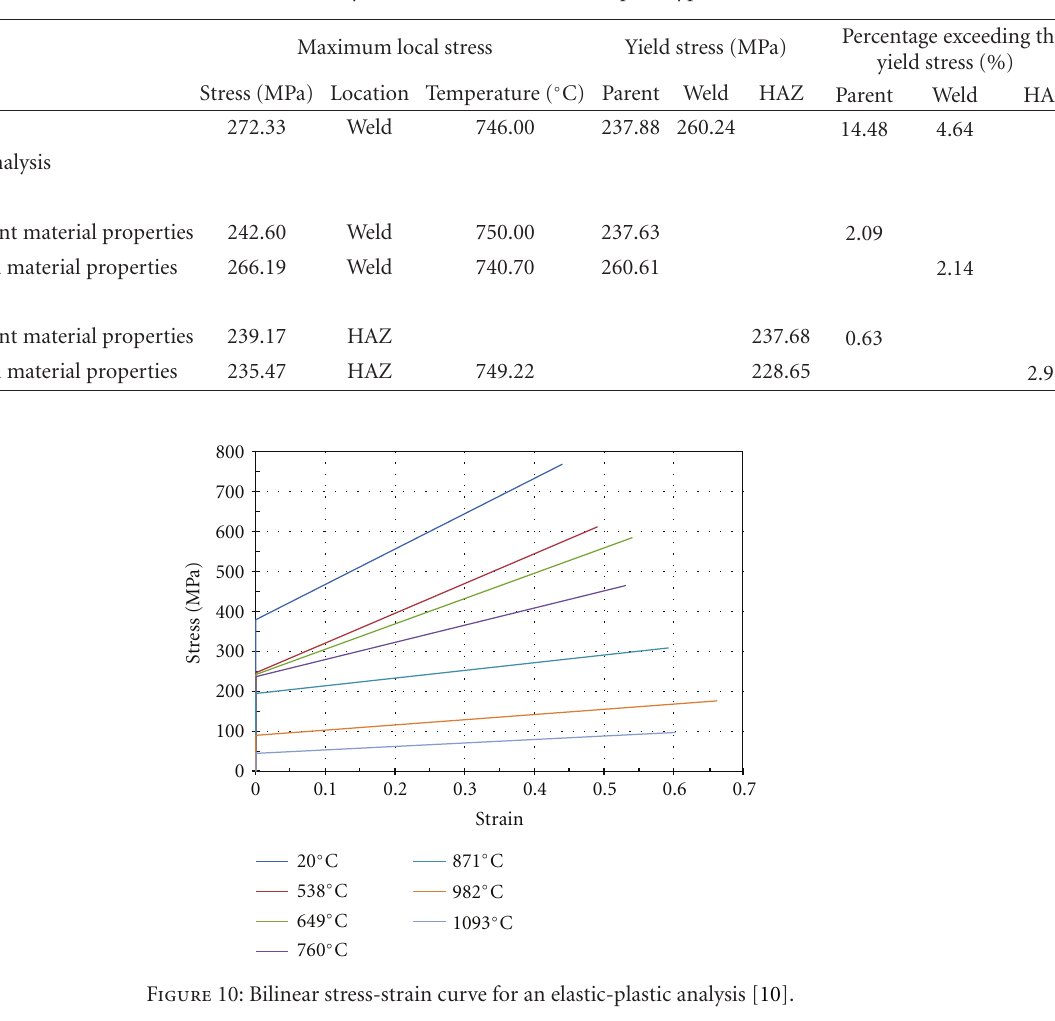
Table 5: Analysis results of 3kW class PHE prototype.